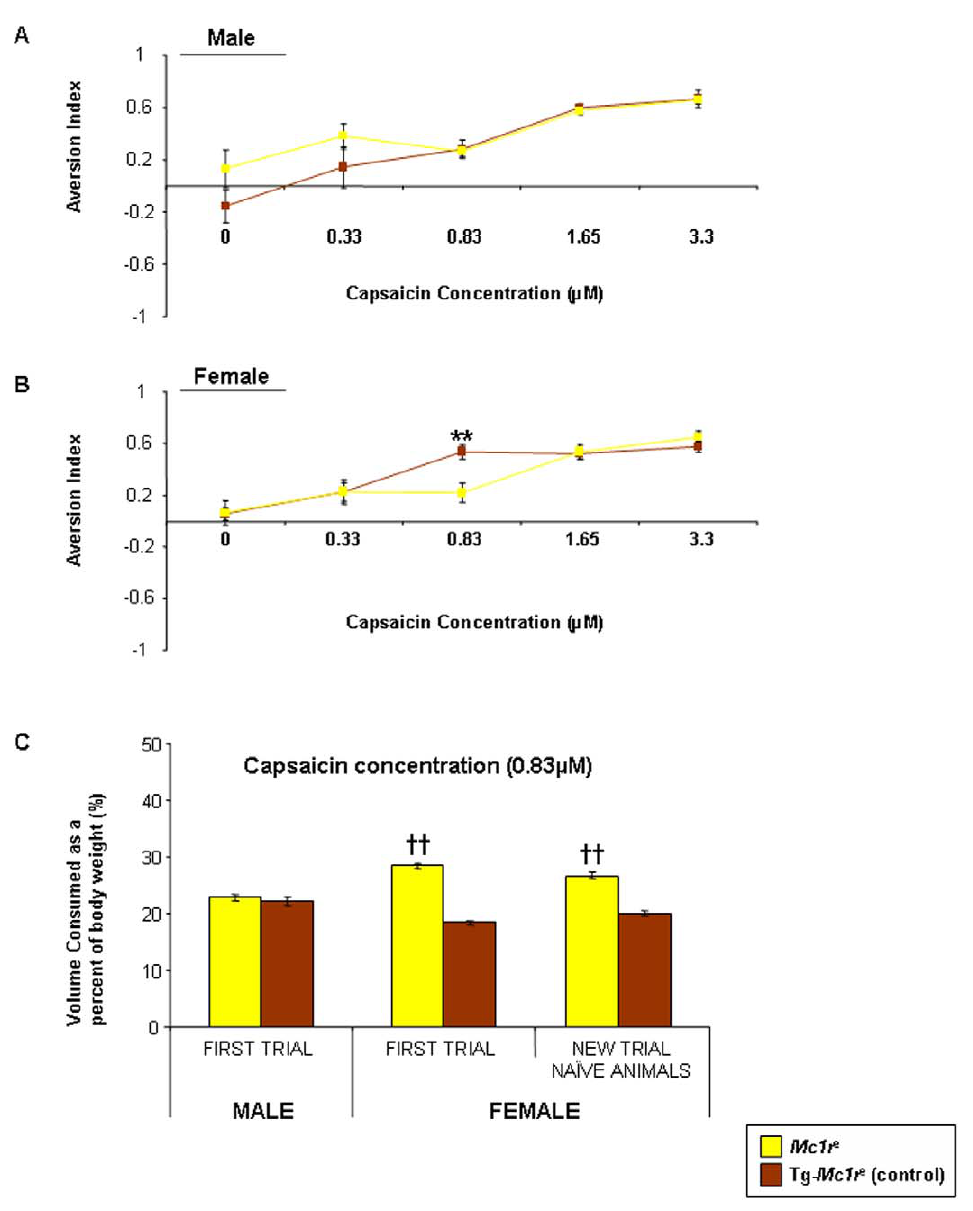
Figure 5. Concentration-dependent aversion to capsaicin consumption. Concentration related aversion to capsaicin in adult [ A ] male and [ B ] female Mc1r e and their control littermates Tg- Mc1r e (n=6–7 per genotype). Data is expressed as an aversion index ranging from 2 1 to 1, which measures the degree to which the solution was avoided during the 10 day exposure at each capsaicin concentration tested 6 SEM and was calculated by subtracting capsaicin consumed from water consumed, differences in Mc1r e consumption of capsaicin are shown (**P , 0.01) compared to control Tg- Mc1r e group. [ C ] Shows the concentration threshold for capsaicin (at 0.83 m M) in the first trial of male and female mice, followed by a repeat trial in naı¨ve animals (not previously assessed for oral aversion) data is expressed as the volume capsaicin containing solution consumed as a percentage of body weight 6 SEM during the 10 day exposure, differences in Mc1r e consumption of capsaicin at 0.83 m M are shown ( {{ P , 0.01) compared to control Tg- Mc1r e